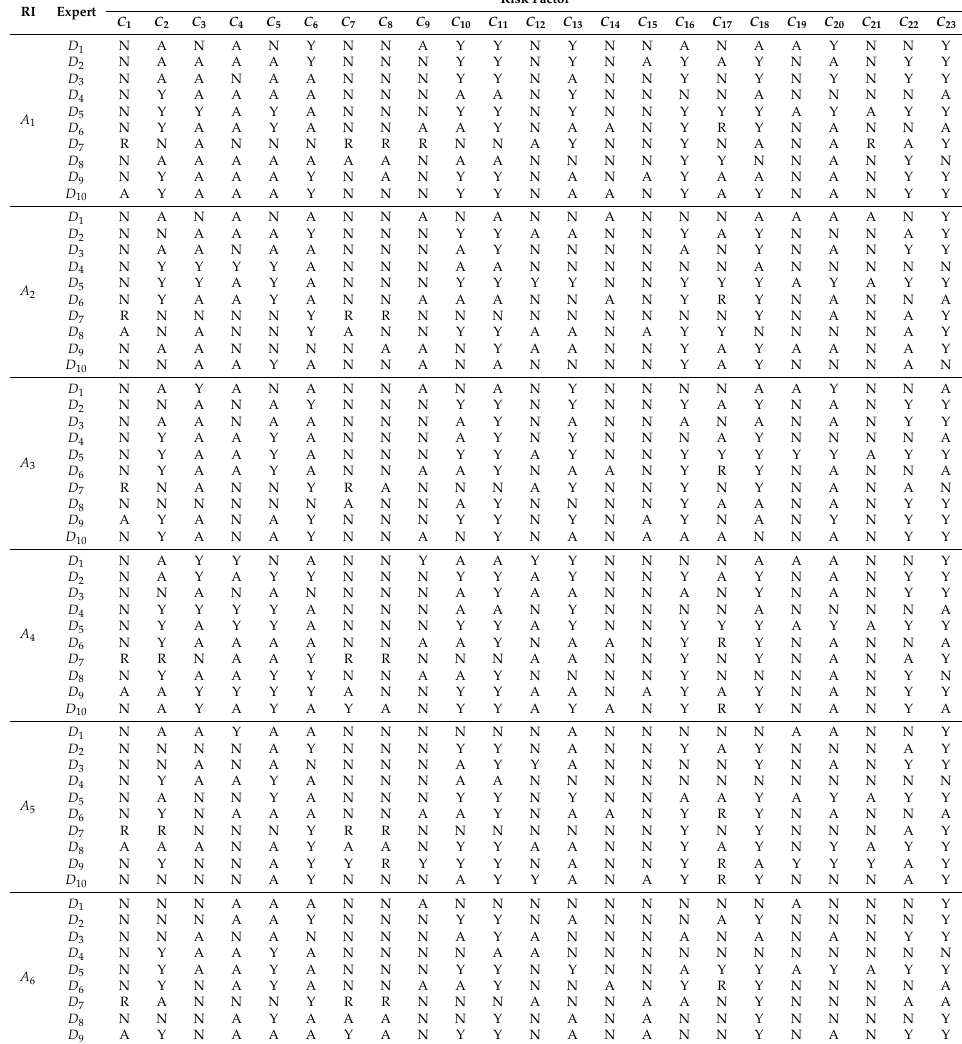
Table 5. Linguistic evaluations of the railway